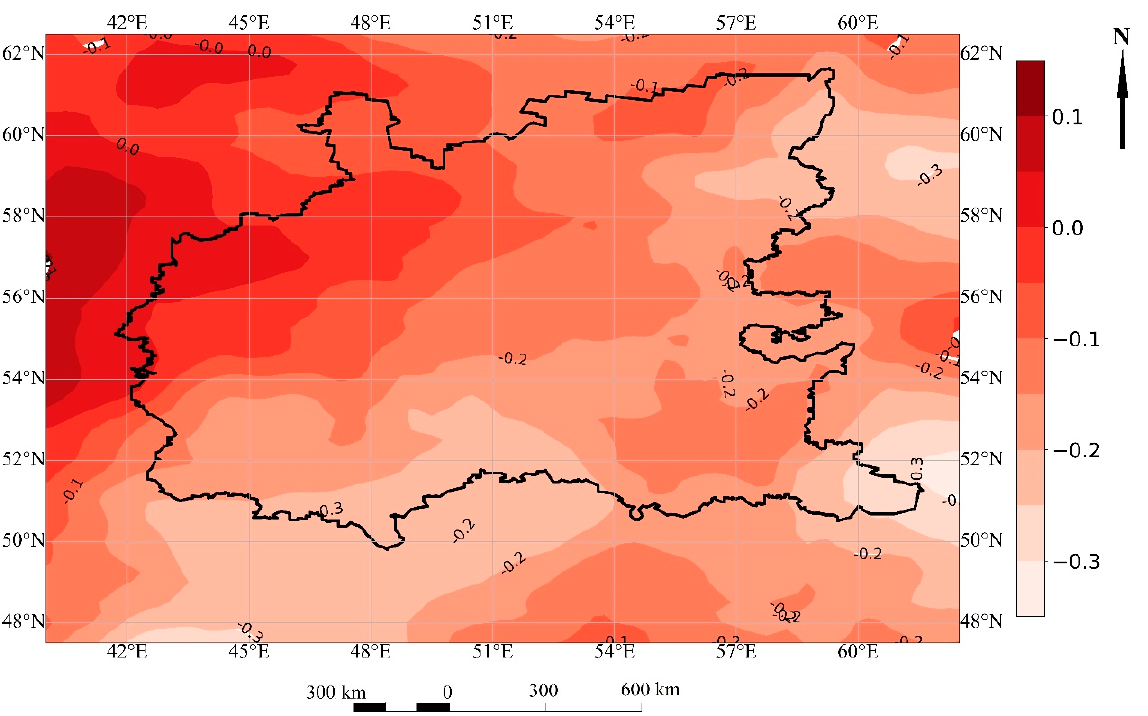
Figure 6. Linear trend of the TT index (K per 10 years) in the Volga Federal District (July 1979–2021). The distribution of the values of the TT index over the study region shows a wide- spread decrease in its values in the warm period (except for May). So, the average (for the VFD) TT trend was: in May, +0.1 K over 10 years; in June, − 0.1 K over 10 years; in July, − 0.2 K over 10 years (with a maximum in the west of the VFD); in August, − 0.4 K over 10 years (with a maximum in the east of the VFD); and in September, − 0.3 K over 10 years (with a maximum in the east of the VFD).